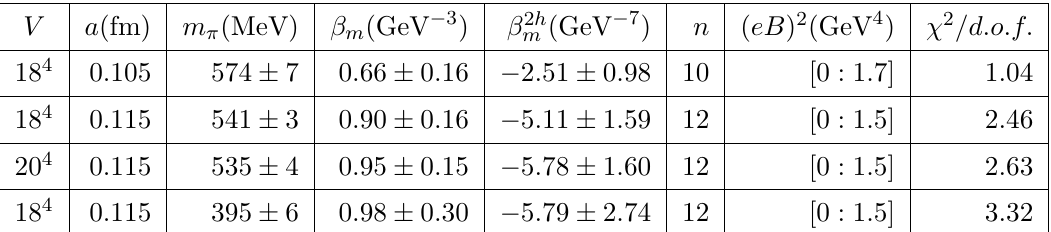
Table 4 . The value of the magnetic dipole polarizability (cid:12) m and the magnetic hyperpolarizability (cid:12) 2 h for the (cid:26) 0 with spin projection s z = 0 are shown for the various lattice volumes V , lattice m spacings a and pion masses m (cid:25) . The degree of polynomial n , (cid:12)eld range used for the (cid:12)tting and (cid:31) 2 =d:o:f values are represented in columns sixth to eighth